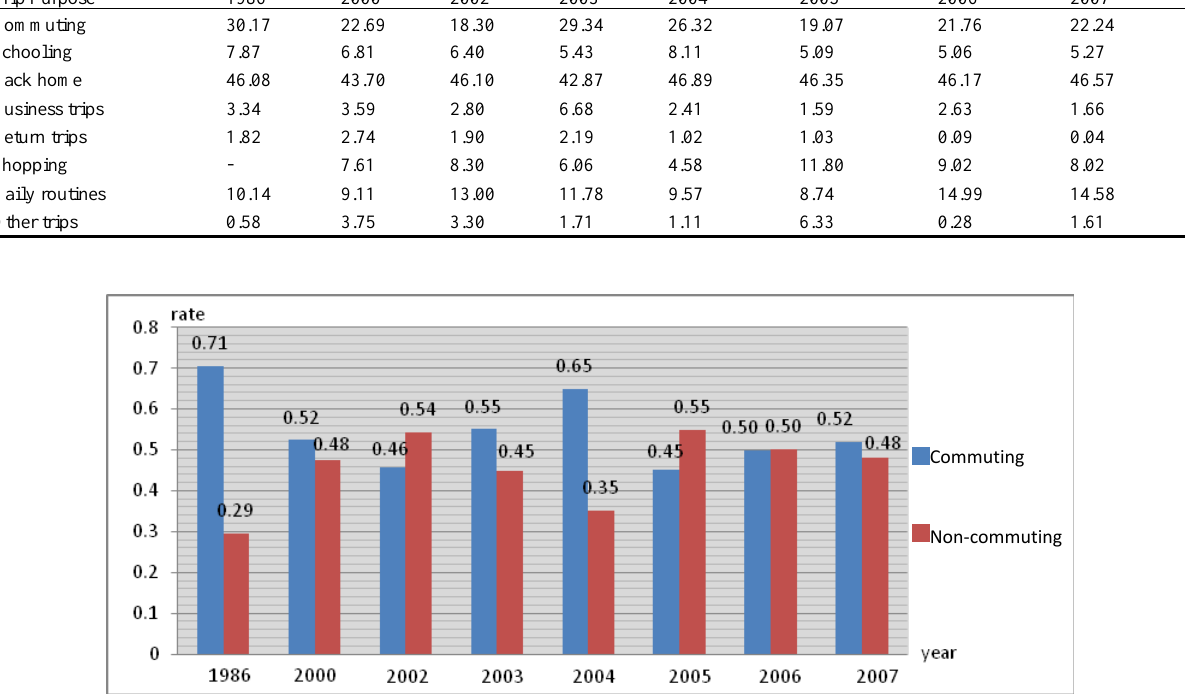
Fig. 4. Rate of commuting and non-commuting travels in Beijing